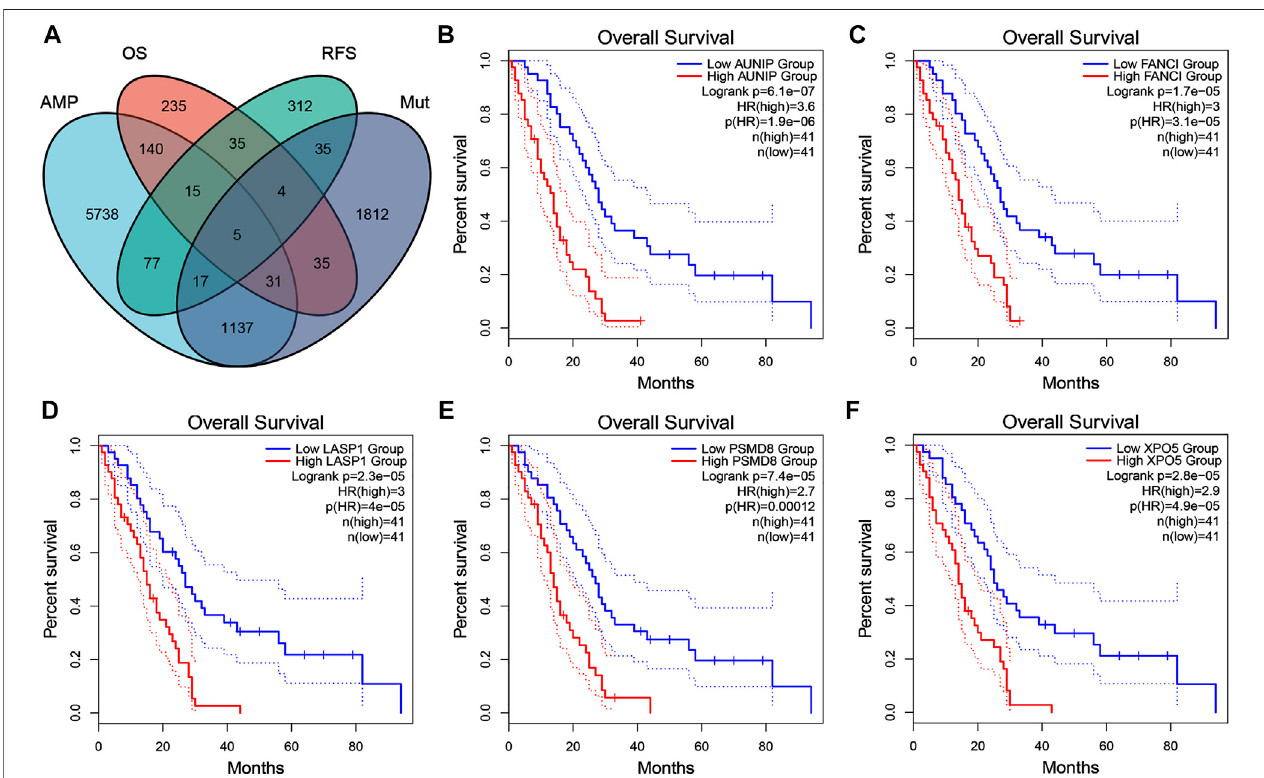
FIGURE 2 | Identi fi cation of tumor antigen candidates related to mesothelioma prognosis (A) A total of fi ve tumor antigen candidates with ampli fi cation and mutation characteristics, signi fi cantly associated with overall survival (OS) and progression-free survival (RFS) (B – F) Kaplan-Meier OS curves based on the expression levels of AUNIP (B) , FANCI (C) , LASP2 (D) , PSMD8 (E) , and XPO5 (F) , respectively.